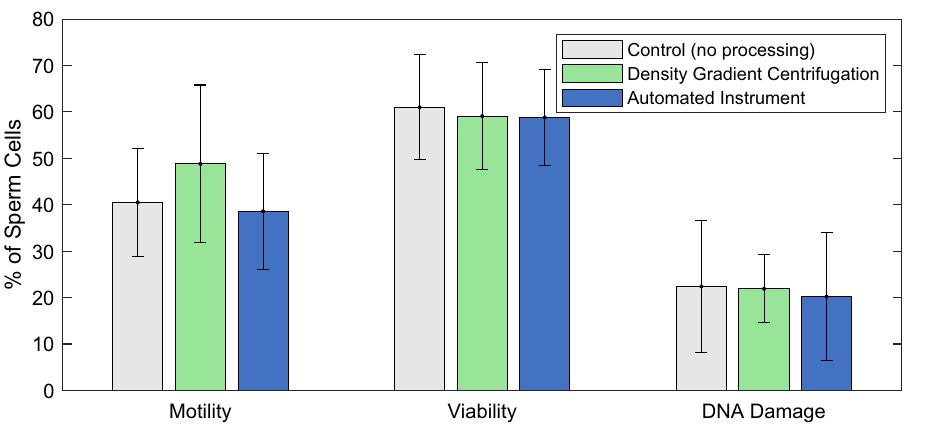
Figure 6. Comparison of sperm quality after processing with a density gradient (DGC) and the automated instrument. Motility (n = 10), Viability (n = 4), and DNA damage (n = 4) results are compared to a control sample that received no processing. All data represent the mean value of the tests, with the error bars representing the standard deviation amongst the